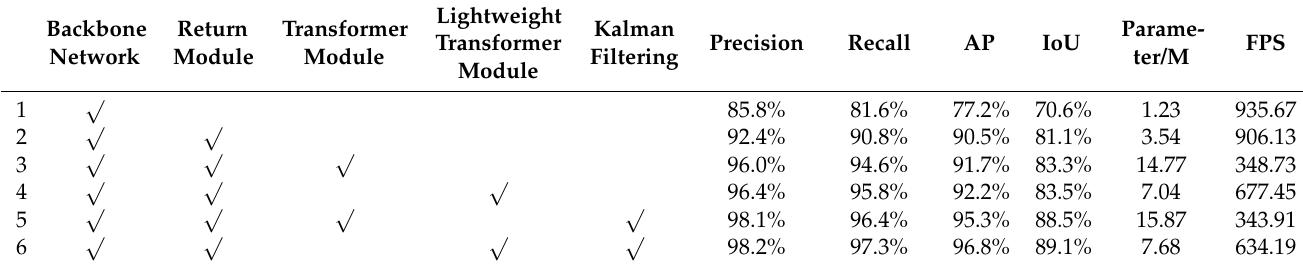
Table 3. Comparative results of ablation